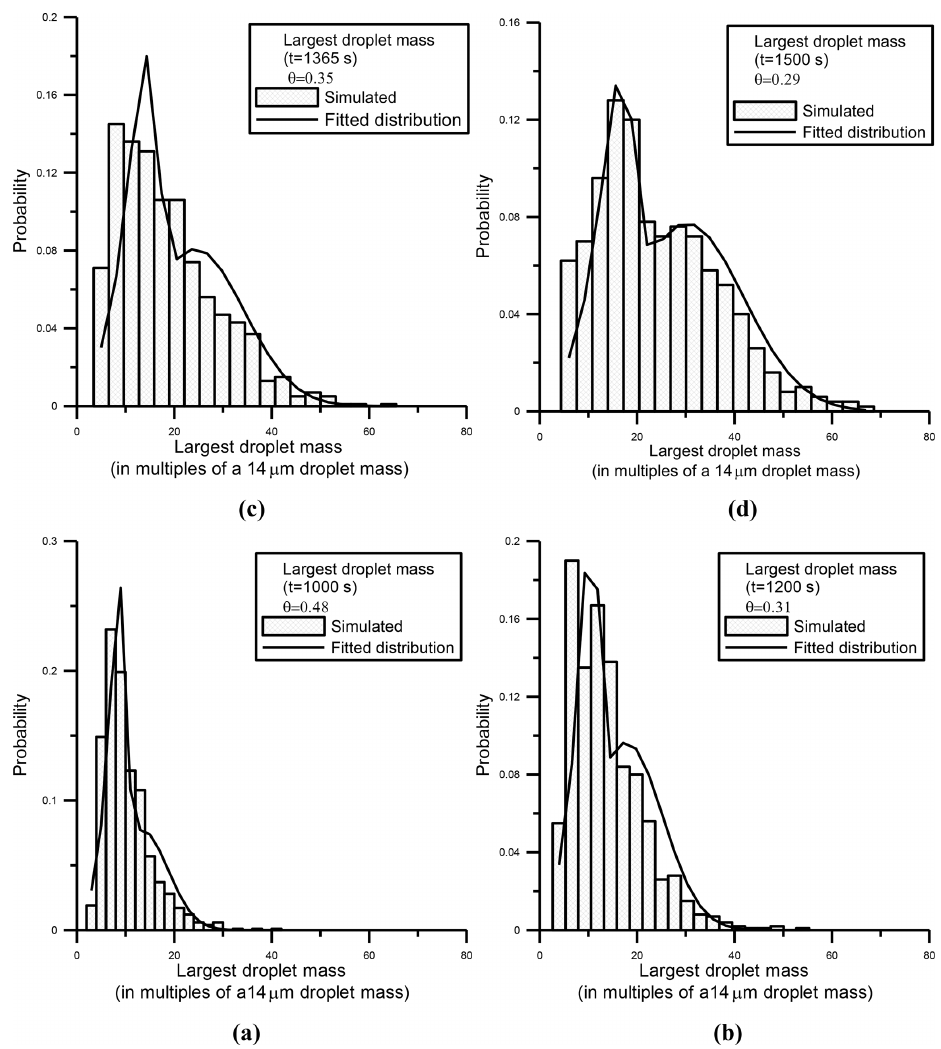
Figure 1. Panels (a) – (d) (histograms) show the largest droplet mass distributions calculated from Monte Carlo simulations at four different times, for a system with an initial mono-disperse distribution of 100 droplets of 14µm in radius. The solid line shows the fit using Eq.